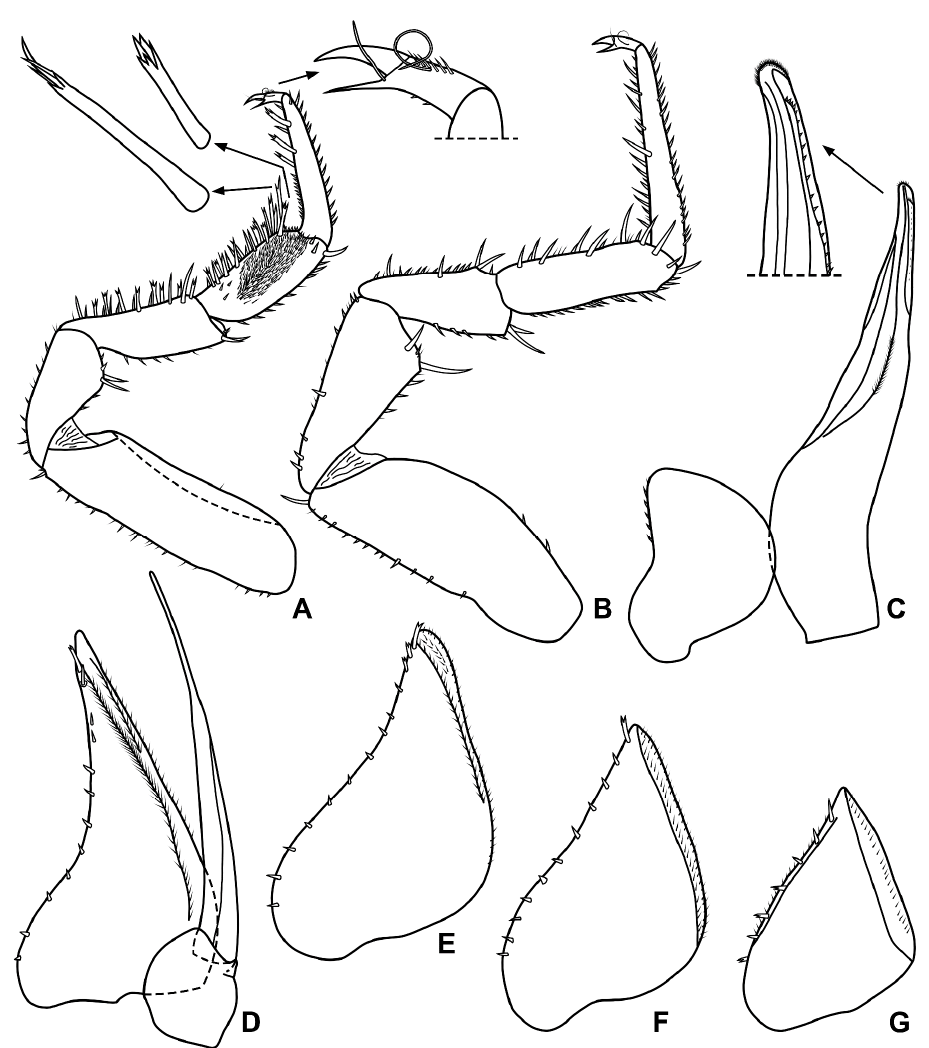
Figure 6. Sardoniscus marmoratus sp. n., paratype ♂ from Tann-a da Scaggia, Bargagli. ( A ) Pereopod 1. ( B ) Pereopod 7. ( C ) Pleopod 1. ( D ) Pleopod 2. ( E ) Pleopod 3 exopod. ( F ) Pleopod 4 exopod. ( G ) Pleopod 5 exopod.